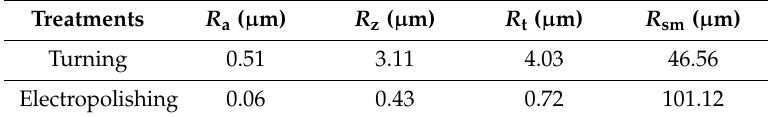
Table 1. Values of several surface roughness parameters of the turned and the electropolished specimens.